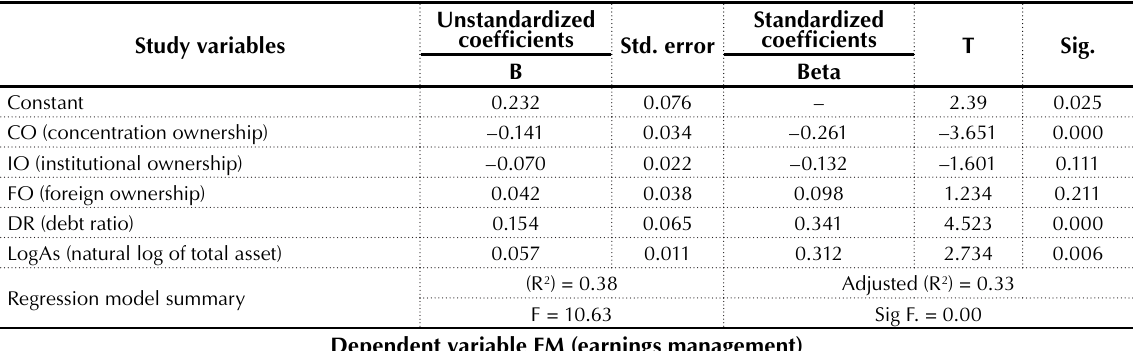
Table 3. Regression results (effect of financial structure on earnings